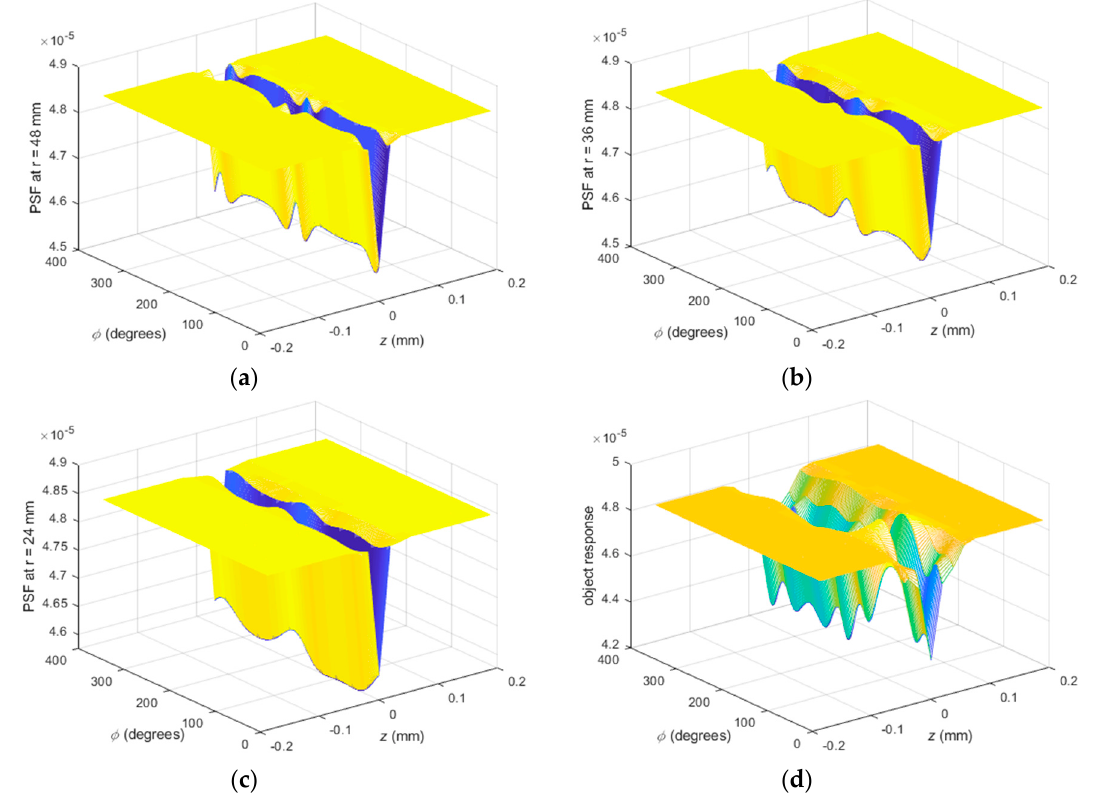
Figure 8. Sample raw responses for the 4th receiver (in the middle) and at frequency of 1.5 GHz: ( a ) point-spread function (PSF) for r = 48 mm, ( b ) PSF for r = 36 mm, ( c ) PSF for r = 24 mm, and ( d ) objects response.